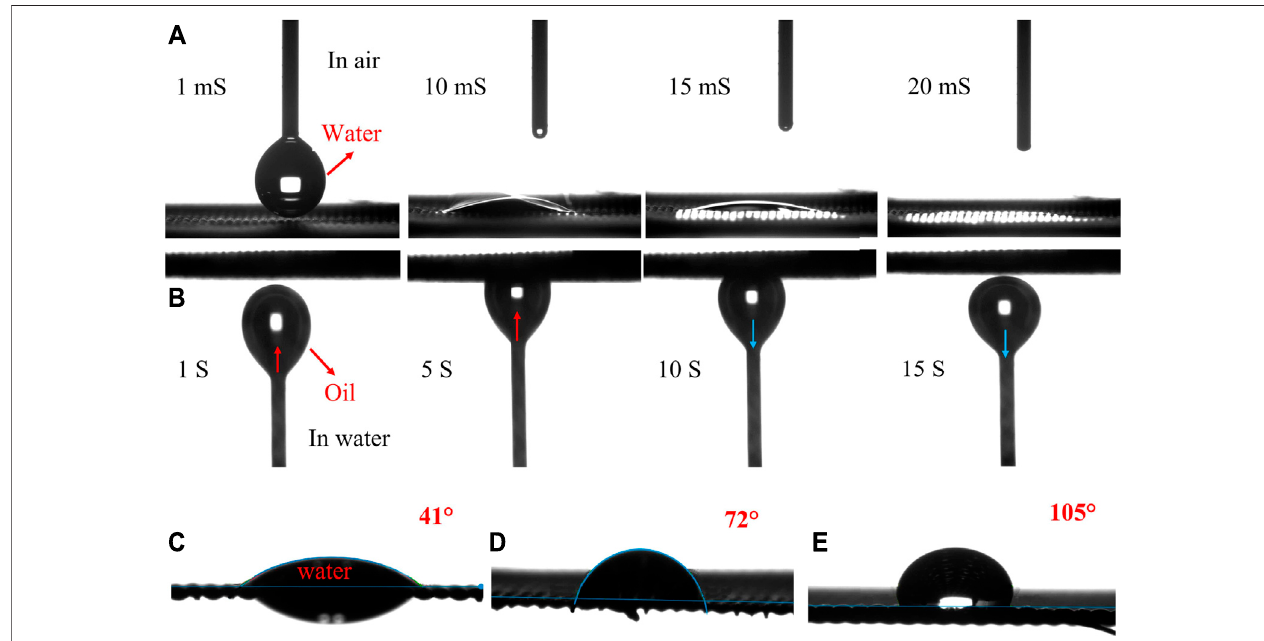
FIGURE 6 | Wettability test of SS meshes. (A) Water contact angle (WCA) test for the zeolite-coated laser-structured SS-100 meshes. (B) Oil contact angle (OCA) test for the zeolite-coated laser-structured SS-100 meshes. (C) WCA for uncoated laser-structured. (D) WCA for coated non-laser-structured. (E) WCA for pristine SS- 100 mesh.